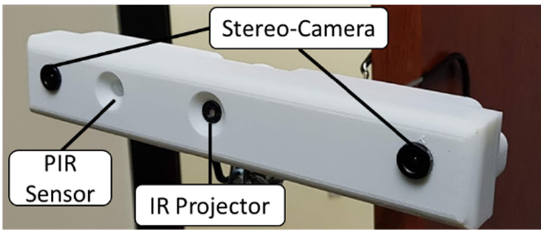
Figure 1. FOODCAM device with a stereo camera, a PIR sensor, and an infrared projector.